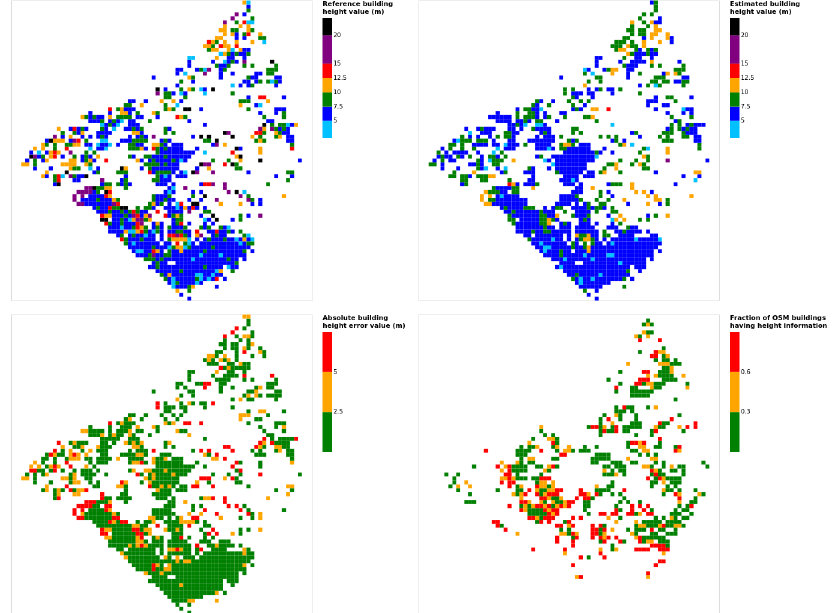
Figure B13. Results for the commune at grid cell (upper left panel) reference building height, (upper right panel) estimated building height, (lower left panel) absolute building height error, and (lower right panel) fraction of OSM buildings that have height information. For all panels except the lower right, only cells that have buildings – with at least 90% of their buildings having no height value in OSM – are displayed.